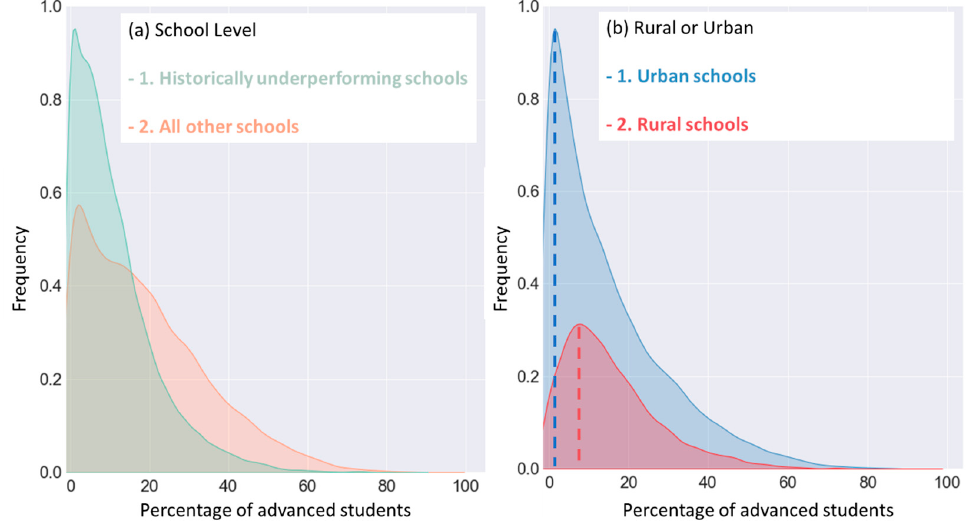
Figure 5. ( a ) The school level affecting academic performance (percentage of advanced students): historically underperforming schools (green line) versus all other schools (orange line); ( b ) rural or urban factors affecting academic performance: urban schools (blue line) versus rural schools (red line).